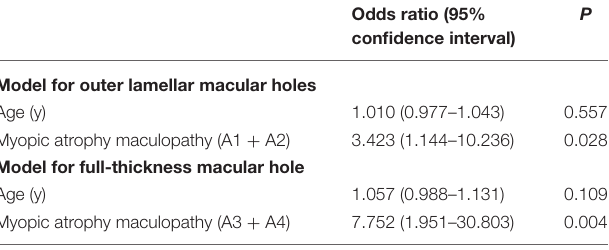
TABLE 4 | Multivariable analysis for outer lamellar macular holes and full-thickness macular holes.